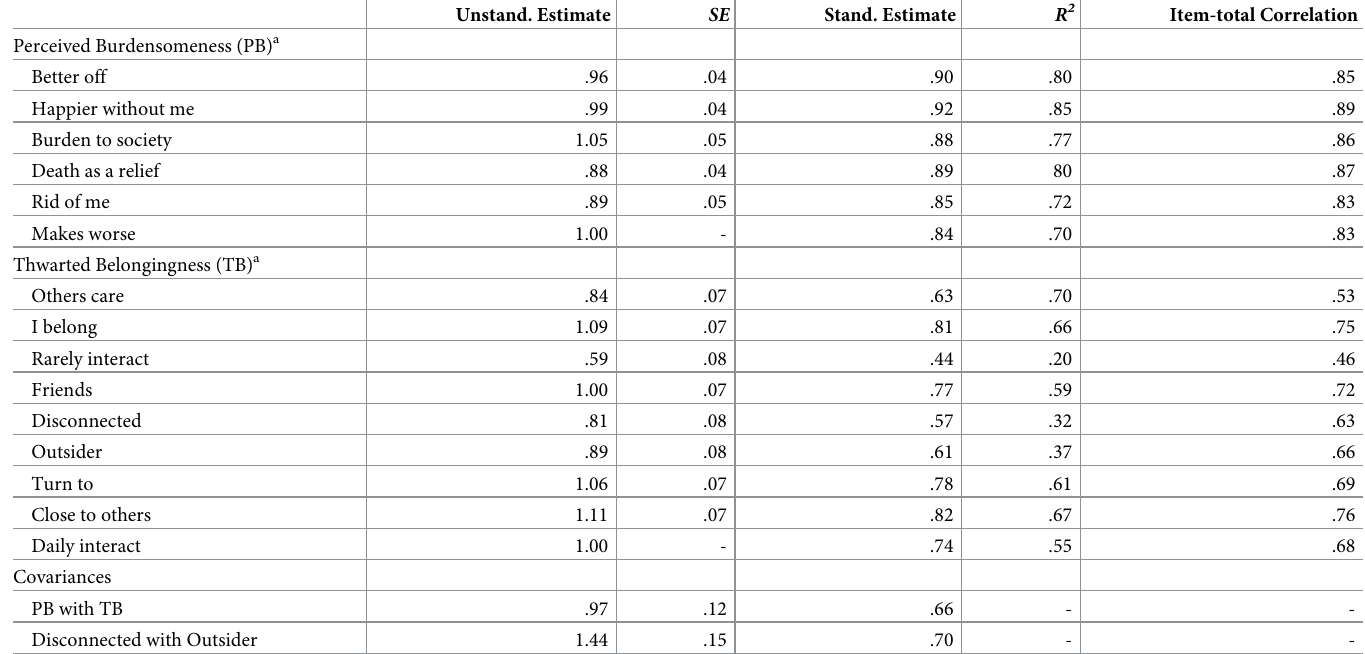
Table 1. INQ -15 Model estimated unstandardized factor loadings (+SE), standardized factor loadings, R 2 values, and item-total correlations.